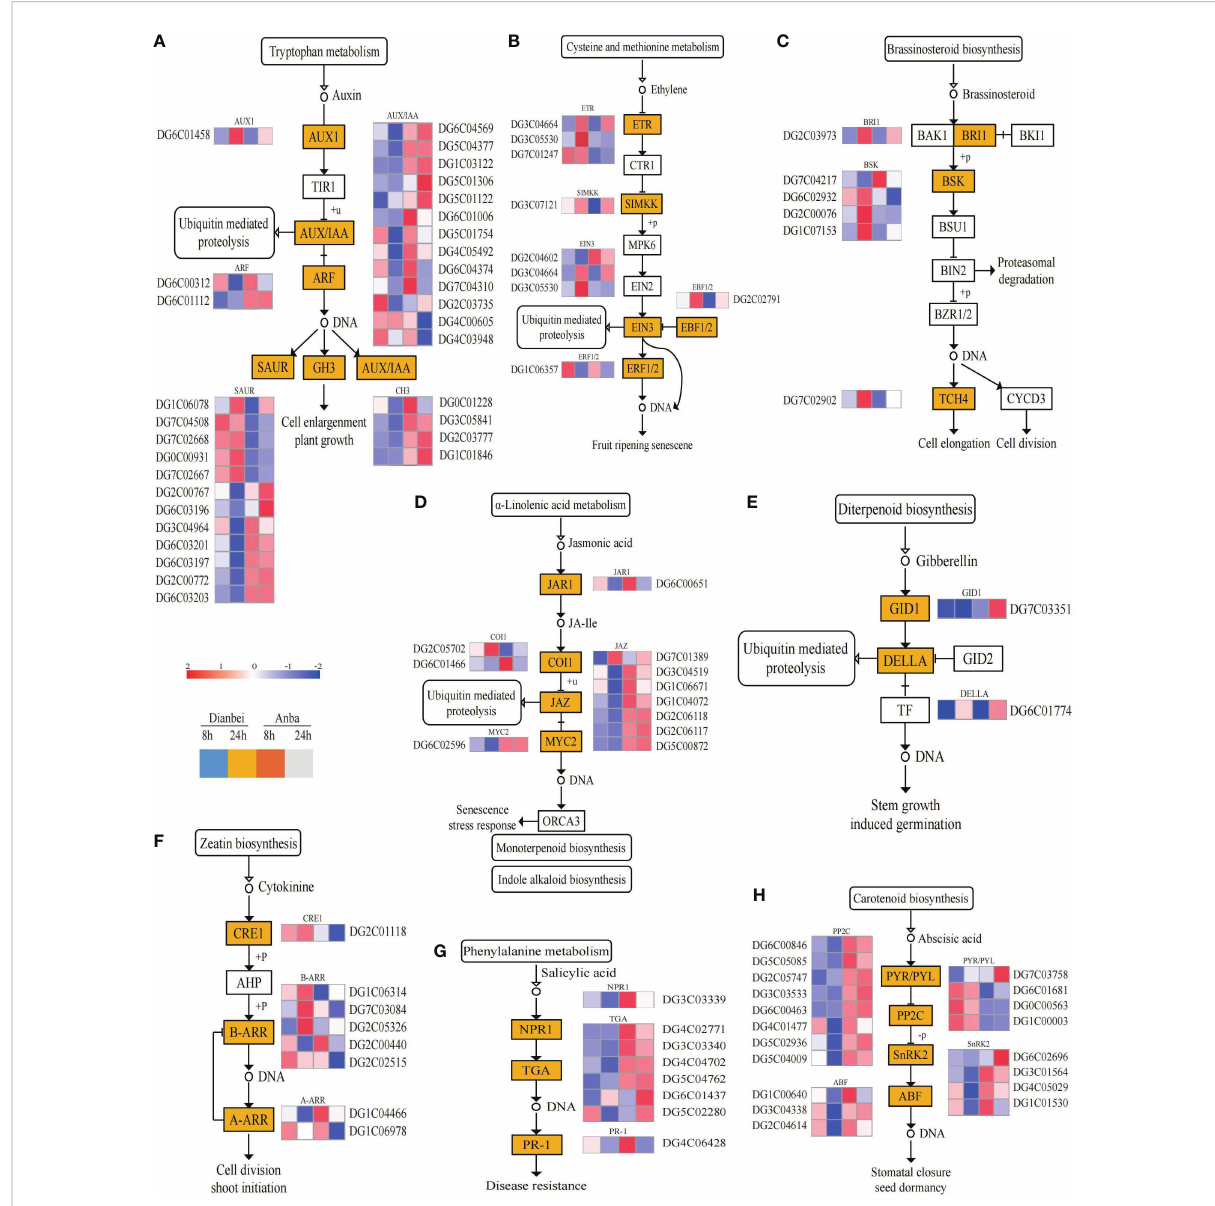
FIGURE 6 Plant hormone signal transduction pathway. (A-H) Auxin (A) , Ethylene (B) , Brassinosteroid (C) , Jasmonic acid (D) , Gibberellin (E) , Cytokinine (F) , Salicylic acid (G) , and Abscisic acid (H) biosynthesis pathway. The y-axis shows the cluster dendrogram of DEGs, and the x-axis shows the sample